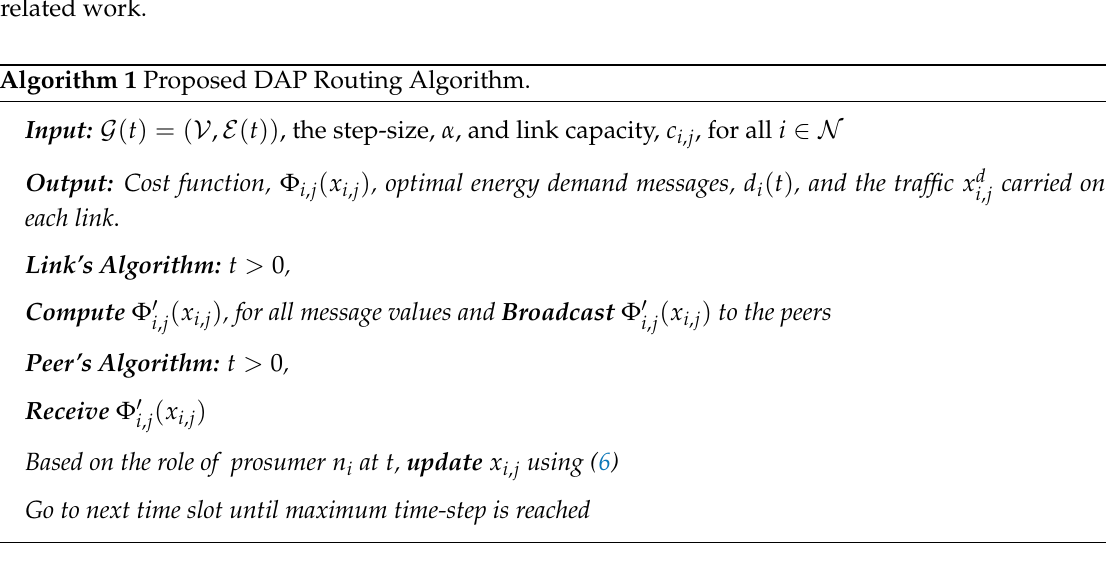
Algorithm 1 Proposed DAP Routing